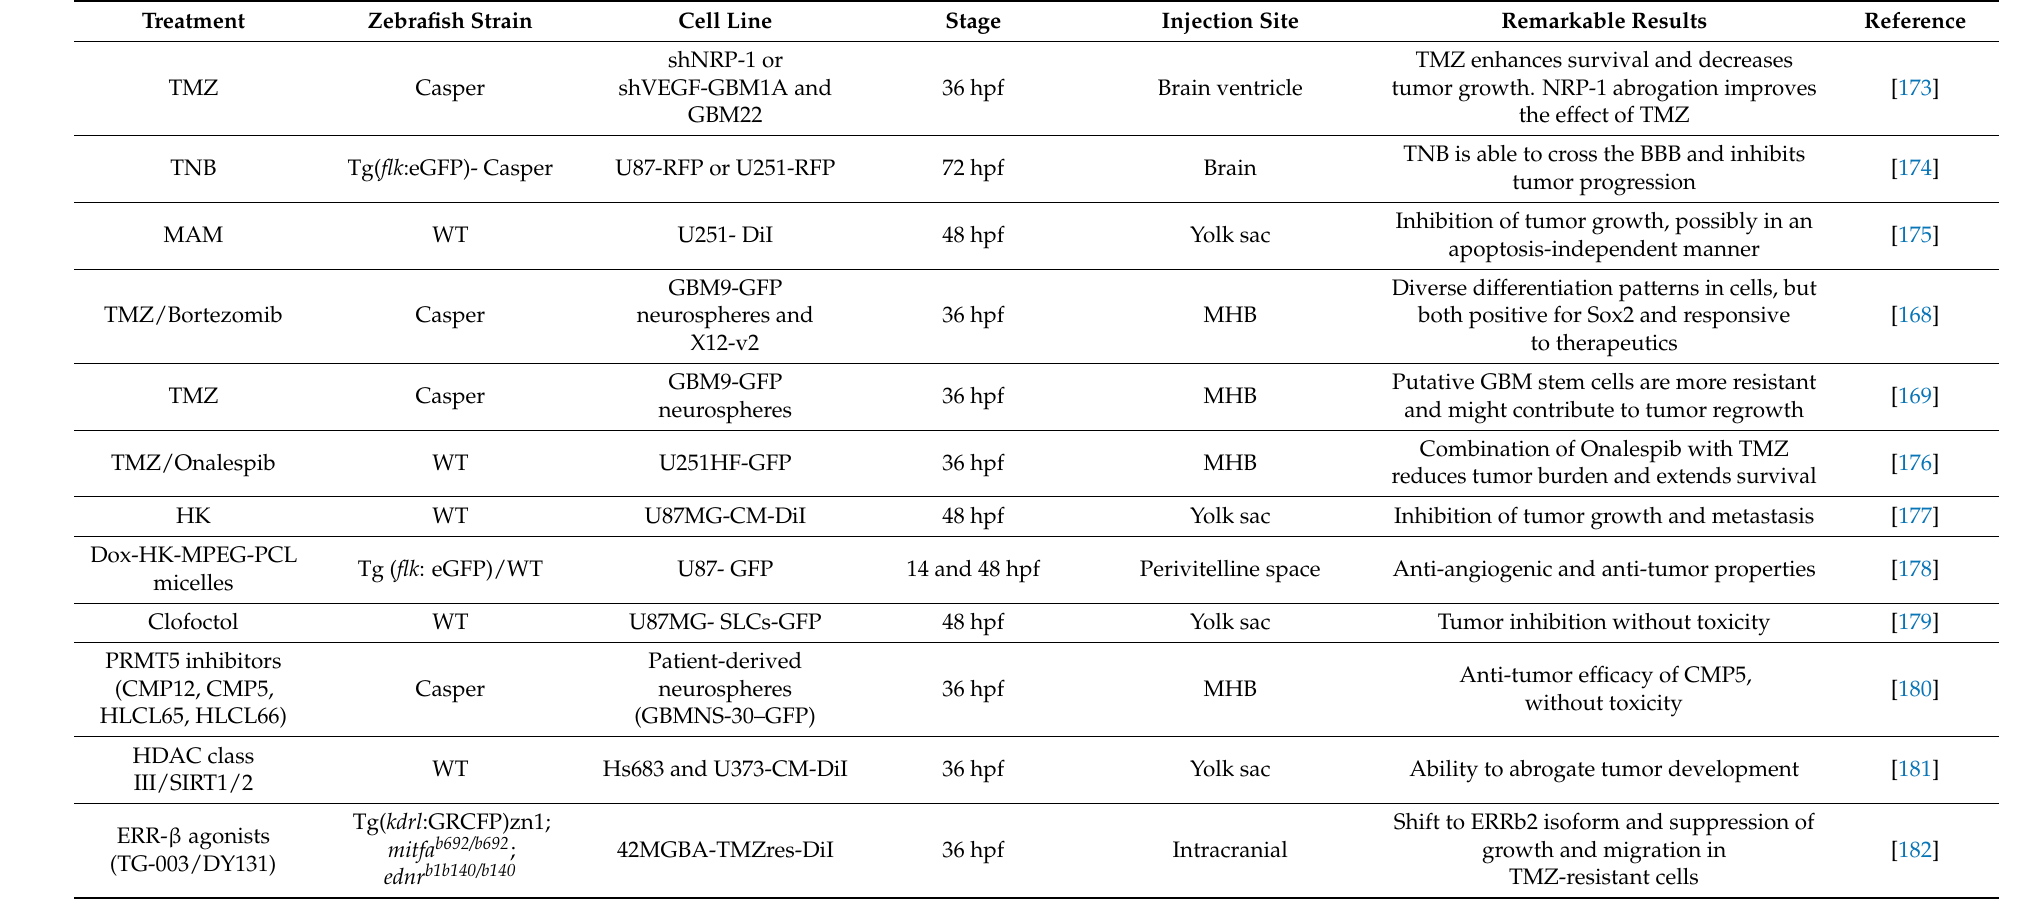
Table 3. Treatments for GBM evaluated using xenograft zebrafish